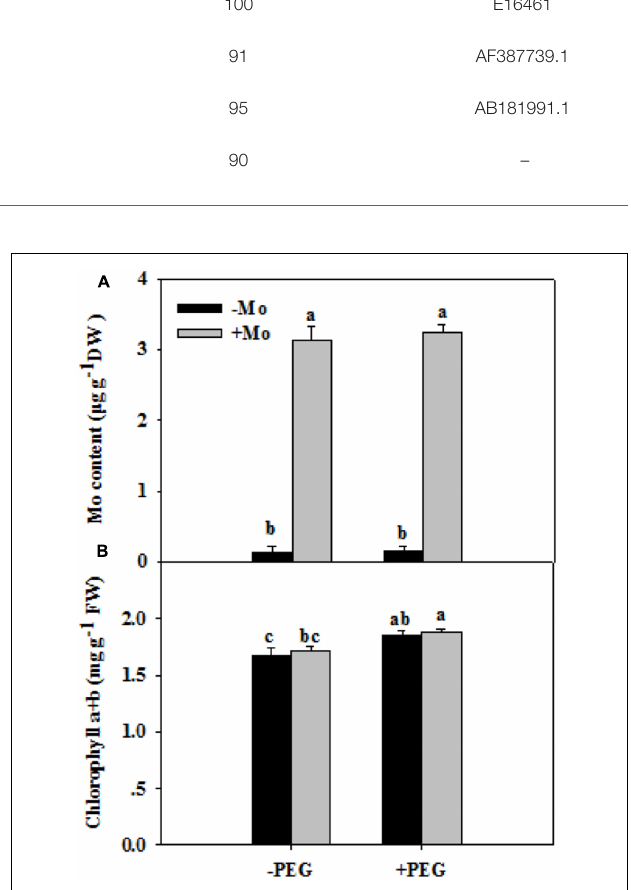
FIGURE 1 | Effects of molybdenum (Mo) application on Mo contents (A) and chlorophyll contents (B) in wheat leaves at 0 and 24 h of polyethylene glycol 6000-simulated drought stress (PSD). –Mo and +Mo treatments represent wheat grown in modified Hoagland solution with 0 and 1 µ M Mo, respectively. –PEG and +PEG represent 0 and 24 h of polyethylene glycol 6000 (PEG) stress, respectively. Different letters indicate significant differences between treatments by the Duncan-test ( p < 0.05, n =